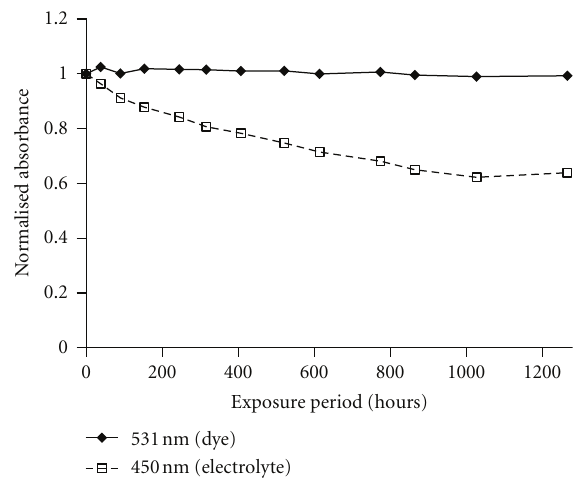
Figure 7: The changing absorbance of the cell at 531 nm (repre- senting dye colouration) and at 450 nm (representing electrolyte colouration) of cells over the exposure period.